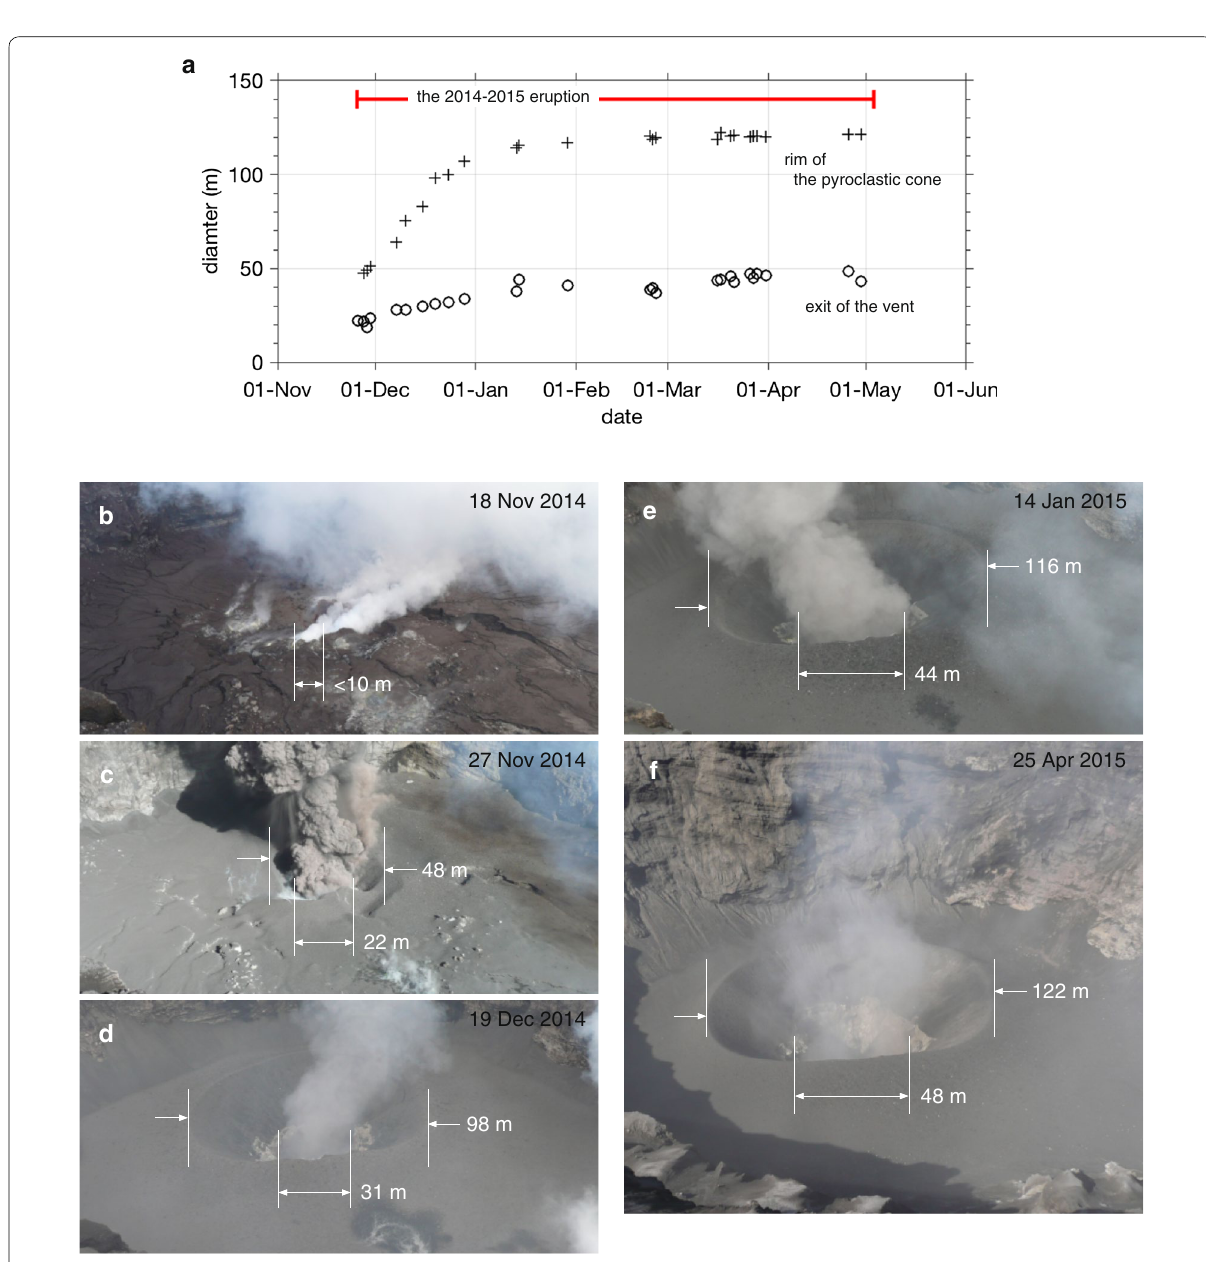
Fig. 3 Time evolution of sizes of pyroclastic cone and its vent. a Size of the pyroclastic cone built at the crater floor (crosses) and the exit of its vent (circles). Red bar indicates the period of the 2014–2015 eruption. b–f Photographs taken from the SSW crater rim showing growth of the pyroclastic cone and its